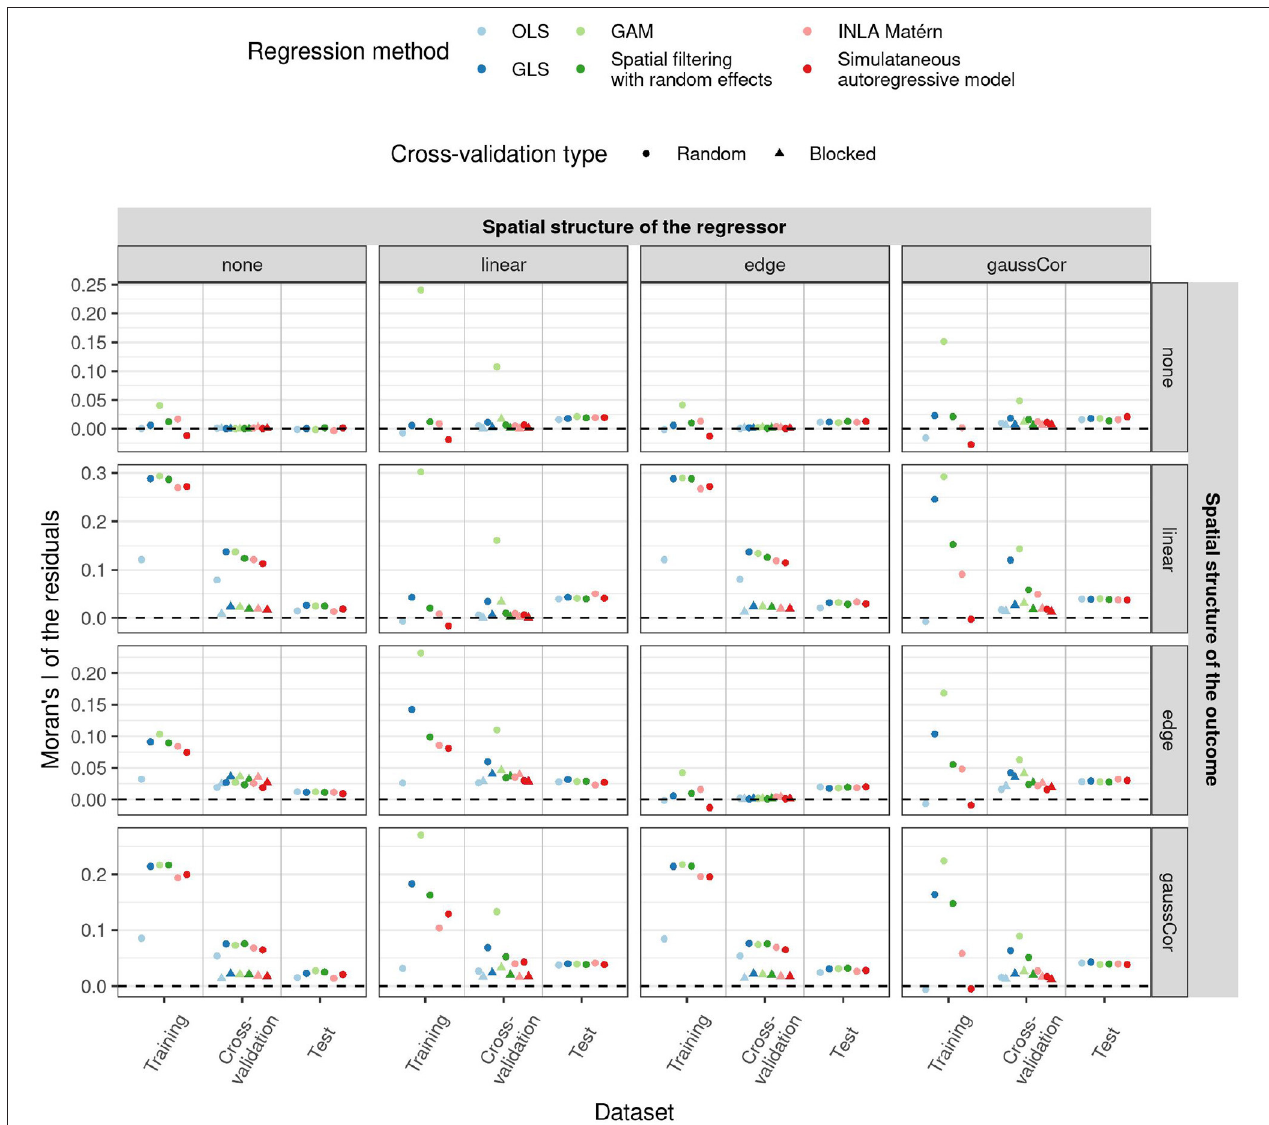
FIGURE 5 | Average Moran’s I statistic for spatial autocorrelation (SAC) of the residuals (y-axis) for the low-dimensional scenario estimated in different ways (x-axis) as a function of regression method (color) and of different correlation structures of the regressors (columns) and outcome (rows) in both test and training data. All statistics had their expected value subtracted from them, such that they all have mean 0 under the null hypothesis of no SAC. Shapes reflect the two different CV paradigms. Since in the low-dimensional scenario, the model fit and hence also the training and test Moran’s I do not depend on the CV paradigm, results for these quantities are only shown for random CV. 1,000 Monte Carlo runs were executed, the standard deviation of the non-zero components of β were